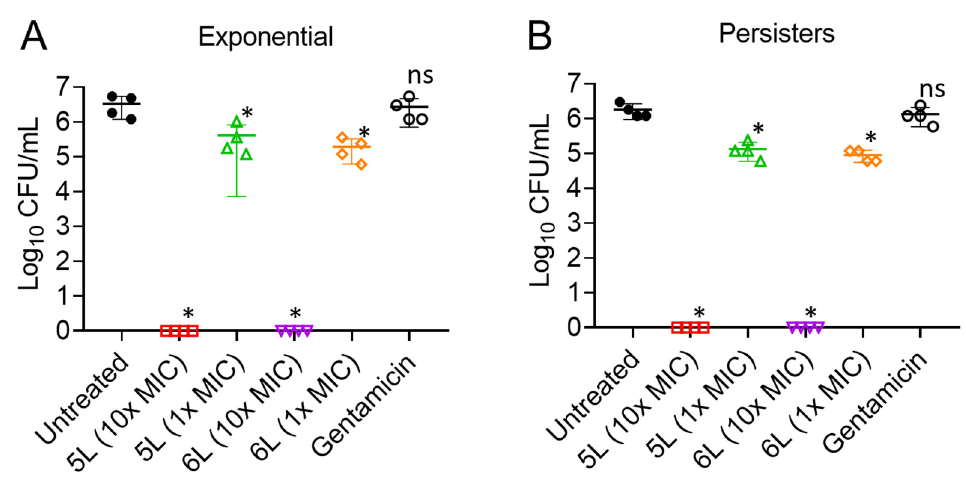
Figure 4. Efficacy of designed LfcinB6 peptides in an ex vivo porcine skin infection model infected with E. faecium C68. ( A ) Bacterial load quantitation (exponential cells) after treatment with peptides 5L and 6L at 10× or 1× MIC. ( B ) Bacterial load quantitation (persister cells) after treatment with peptides 5L and 6L at 10× or 1× MIC. (* p < 0.05 are significant, determined by one way ANOVA). ns: not